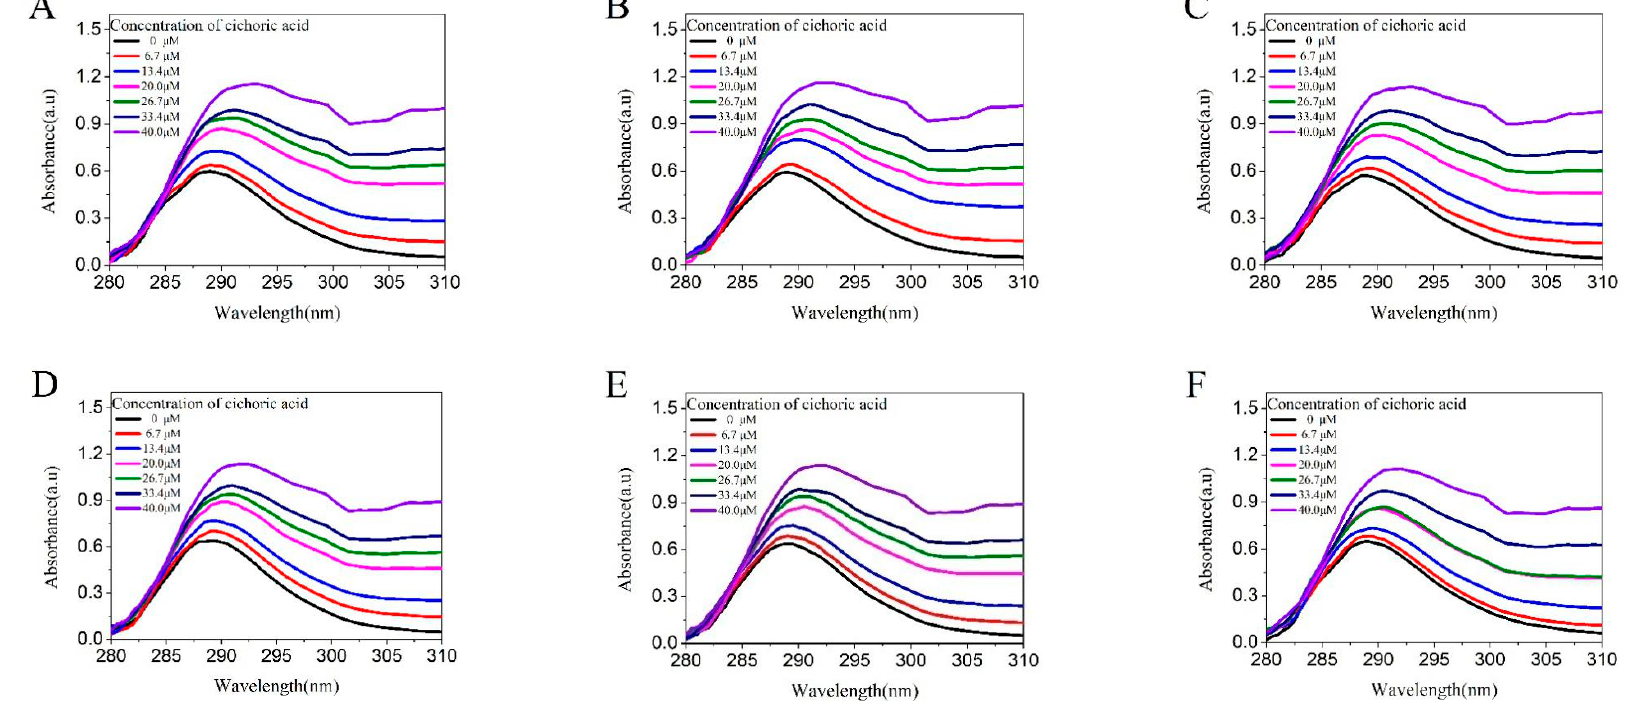
Figure 3. UV–VIS absorption spectra of 25 mM LF at pH 4.0 (curve A – C ) and pH 7.0 (curve D – F ) in the presence of CA with concentrations in the range of 0 to 40 μ M upon excitation at 295 nm, and ( A , D ) were at 25 °C, the ( B , E ) were at 70 °C, and ( C , F ) were at 95 °C.